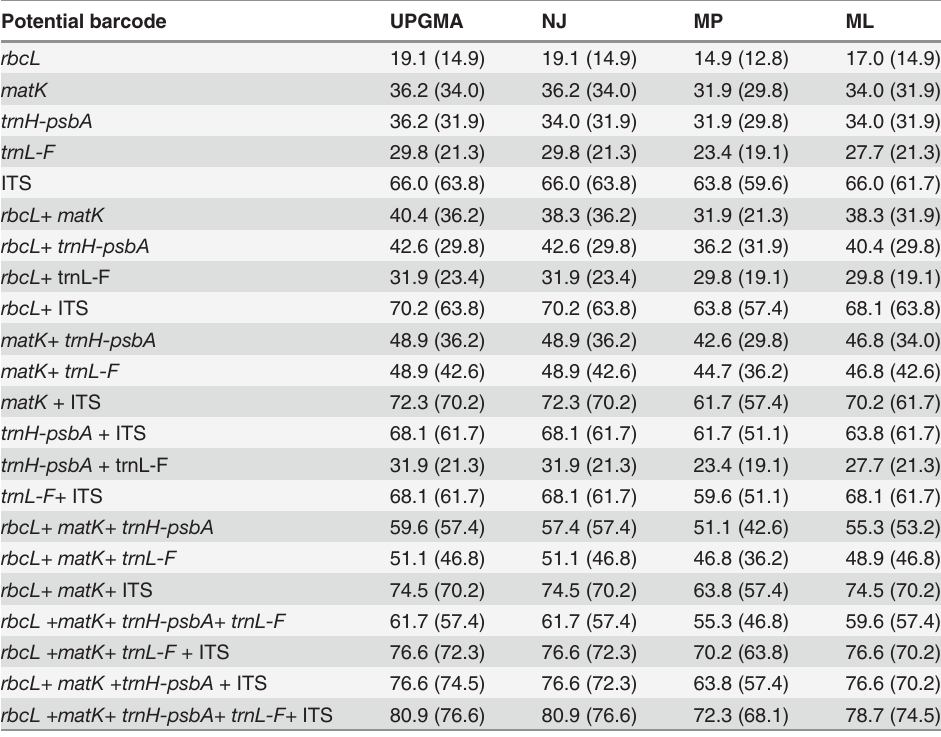
Values outside of the parenthesis represent percentage of species-level monophyly; values in the parenthesis indicate species-level monophyly with bootstrap value (cid:1)